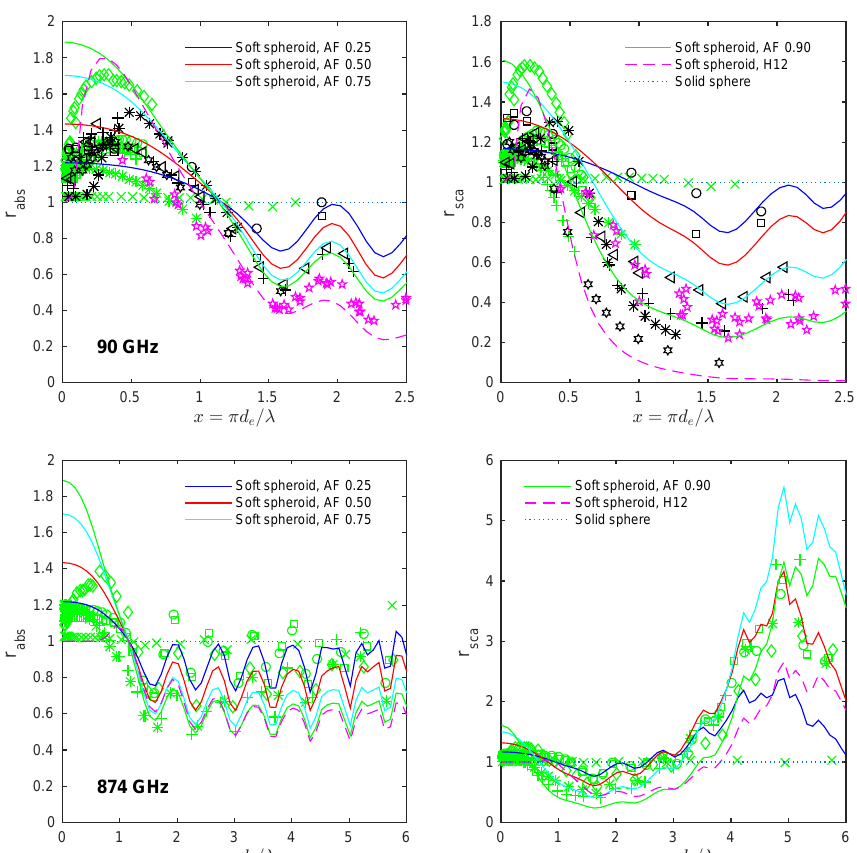
Figure 7. Normalised absorption (left) and scattering (right). The top row includes 90GHz Hong/Liu and 89GHz Nowell data, while the bottom row covers 874GHz. The soft spheroids have either a fixed air fraction (AF) or follow Hogan et al. (2012), denoted as H12. Normalisation and plotting symbols used for DDA data are as in Fig.